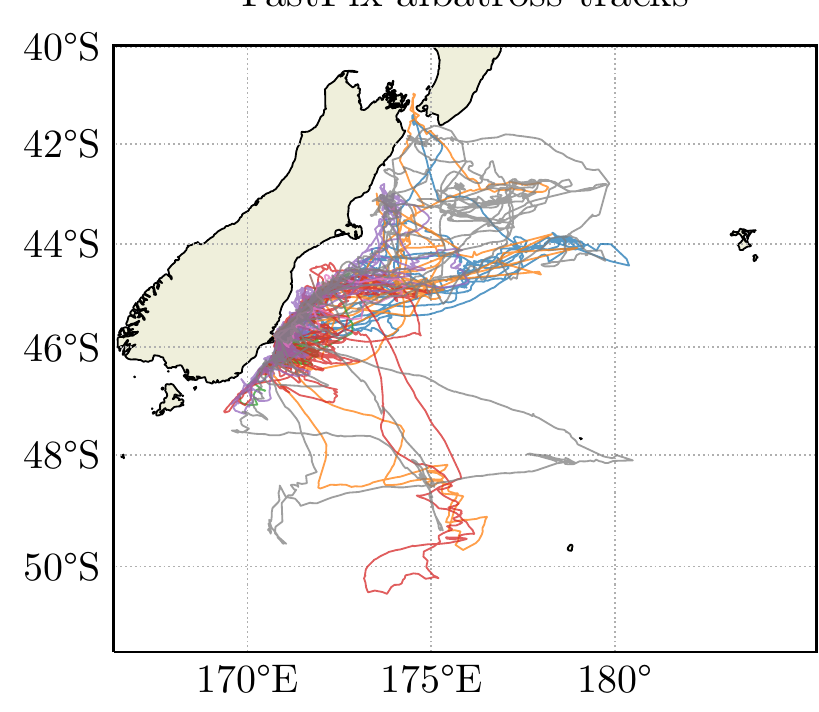
Figure 9. Position estimates recovered from 8 tags attached to Royal albatross over a one-month period off the coast of the South Island of New Zealand. There are 26,042 fixes. Each colour represents a different animal, showing the remarkable ability of these animals to navigate over the long distances traveled during feeding